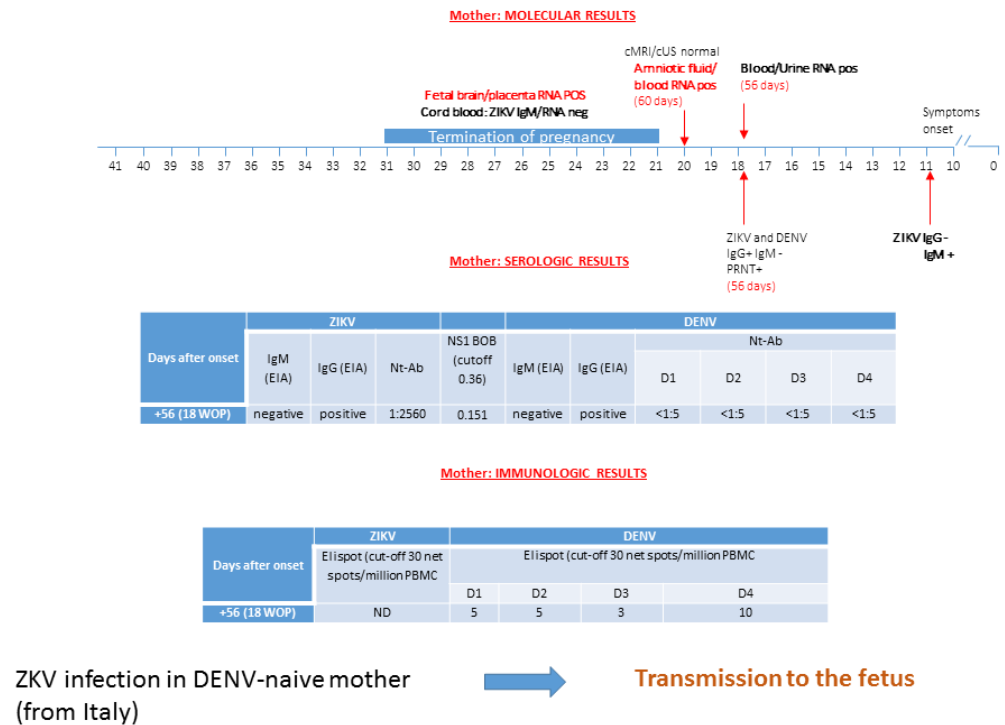
Figure 4. ZIKV infection in a DENV-naïve mother is reported. Diagnosis was performed using molecular, serological, and immunological assays, and transmission to the fetus was reported. cMRI/cUS: cerebral magnetic resonance imaging/cerebral ultrasonography; PRNT: plaque reduction neutralization test; WOP: week of pregnancy; EIA: enzyme immunoassay; IFA: immunofluorescence assay; Nt-Ab; neutralizing antibodies. ND: not done. In the box of molecular diagnosis, black numbers specify the week of pregnancy, while red numbers in brackets indicate the exact day of gestation. BOB assay result is expressed as the ratio of inhibition, while ELISpot assay is measured as net spots/million PBMC.